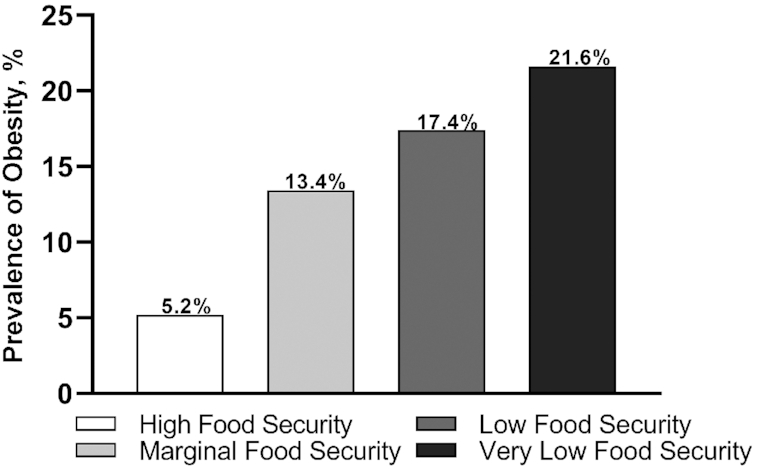
Prevalence of obesity (BMI ≥30 kg/m2) by food security status among second-year college students (n = 683), 2017. The prevalence of obesity increases with worsening food security status [χ2 (3) = 26.11, P < 0.001].